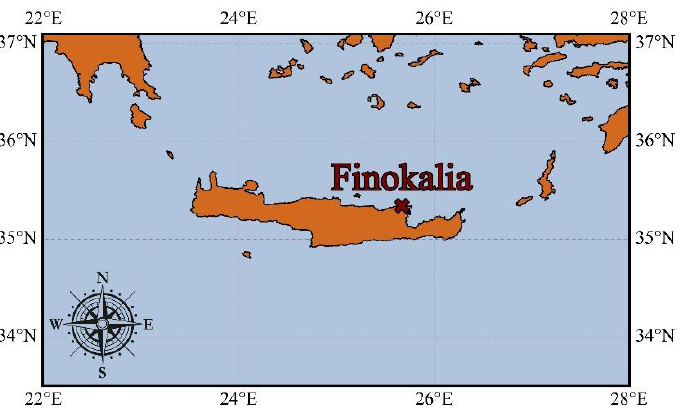
Figure 1. Finokalia station (35.34°N, 25.67°E, 250 m a.s.l.) on the north coast of Crete.